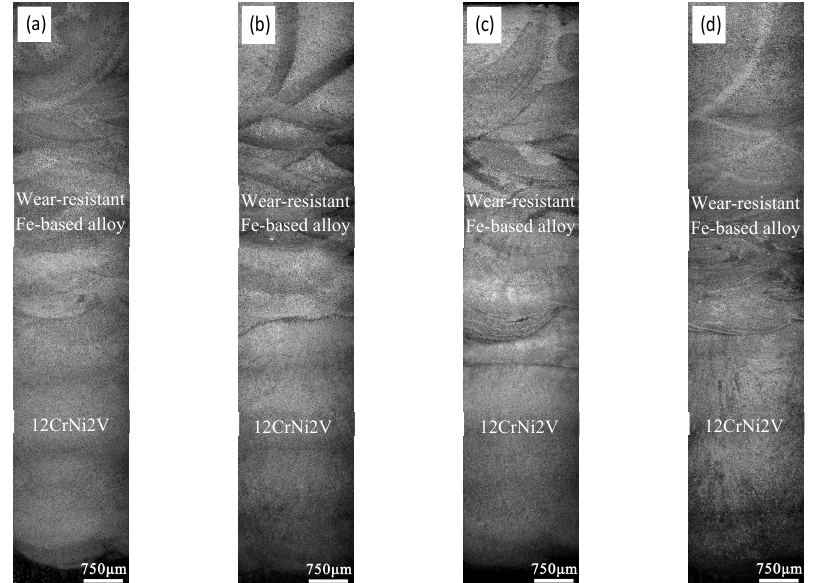
Figure 4. Cross section of the laser melting deposited Fe-based alloy gradient materials at low magnification ( a ) S1; ( b ) S2; ( c ) S3; ( d ) S4.